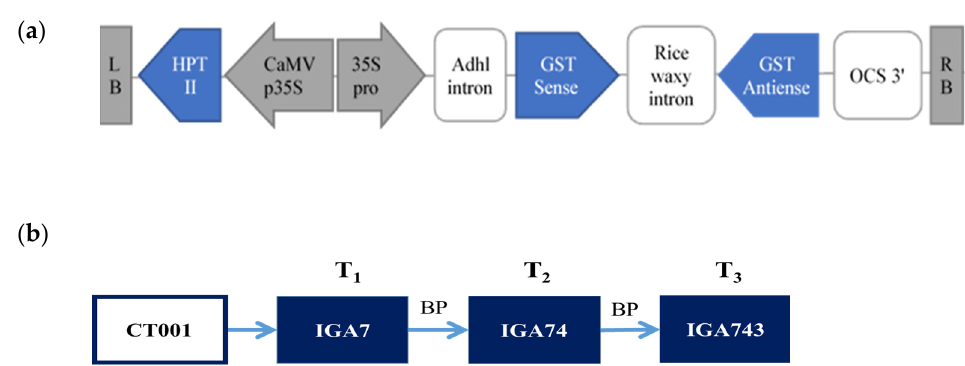
Figure 1. Schematic map of the T-DNA region of the glutathione S-transferase (GST) RNAi binary vector used for Chinese cabbage transformation ( a ) and strategy for construction of the progeny lines of transgenic Chinese cabbage plant, IGA7 ( b ). LB, left border; HPT II, hygromycin resistant gene; CAMV35S and 35S pro, cauliflower mosaic virus 35S promoter; Adhl intron, intron of the alcohol dehydfogenase-7 (Adhl) gene; GST sense, glutathione S-transferase gene; OCS-3 ′ , The 3 ′ - flanking region of octopine synthase gene; RB, right border.